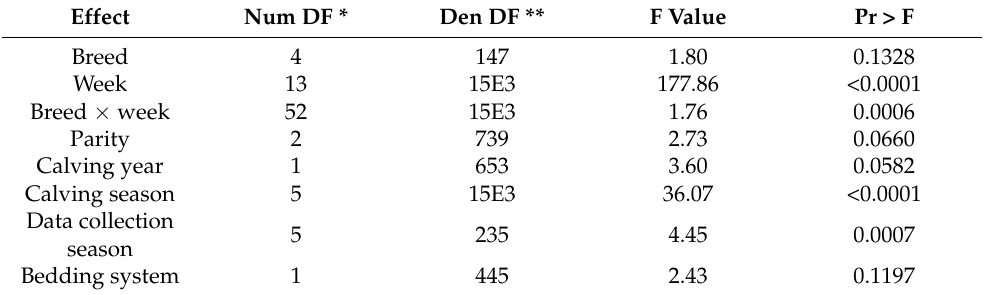
Table A10. Variance analysis results for the variable fat (%).